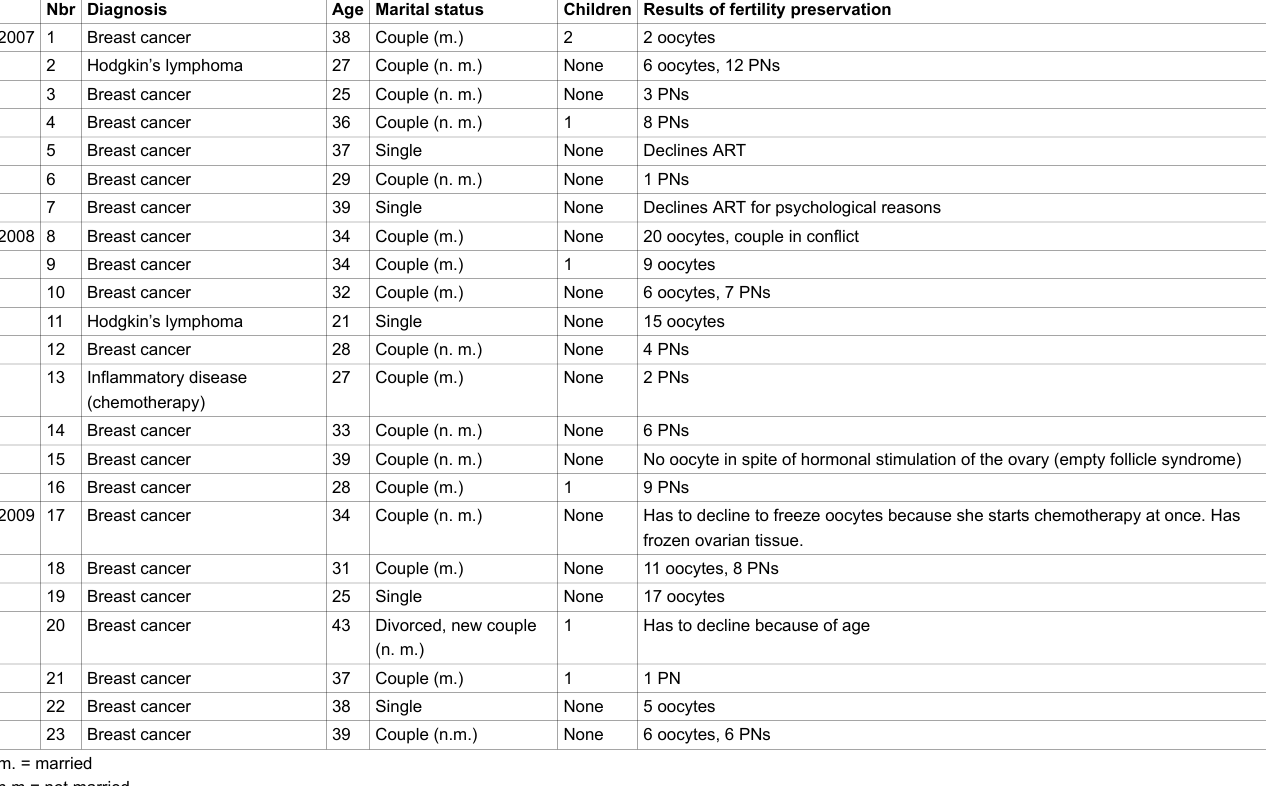
Table 1 Patients who were offered psychological counselling within the framework of the programme “Cancer and Fertility” at the University Women’s Hospital, CHUV, Lausanne. Nbr